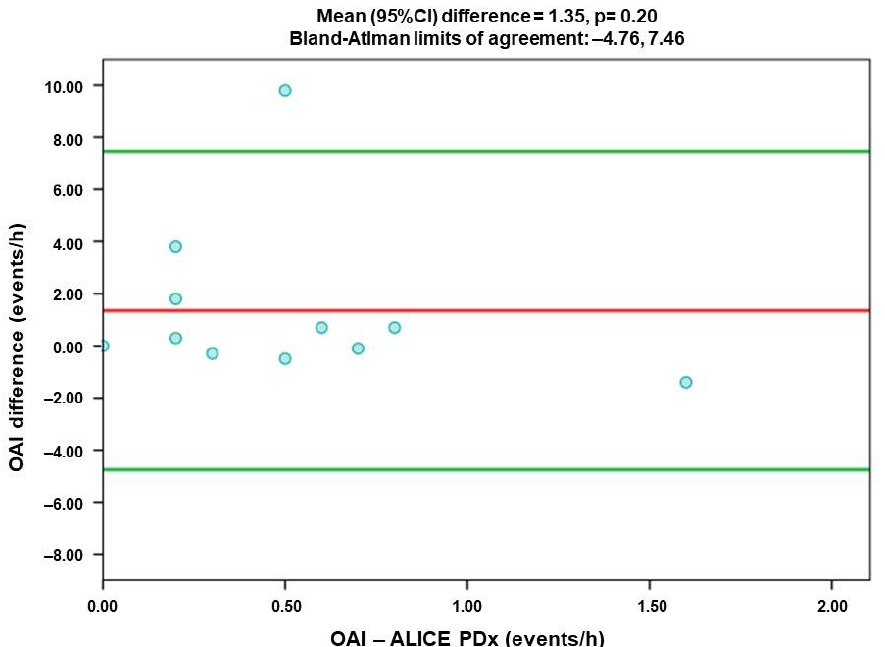
Figure 3. Bland-Altman plots. Distinction between the OAI-Alice PDx plotted against the two de- vices’ OAI difference ( n = 11). The red line presents the mean difference, while the green ones pre- sent the limits of agreement. OAI: obstructive apnea index.